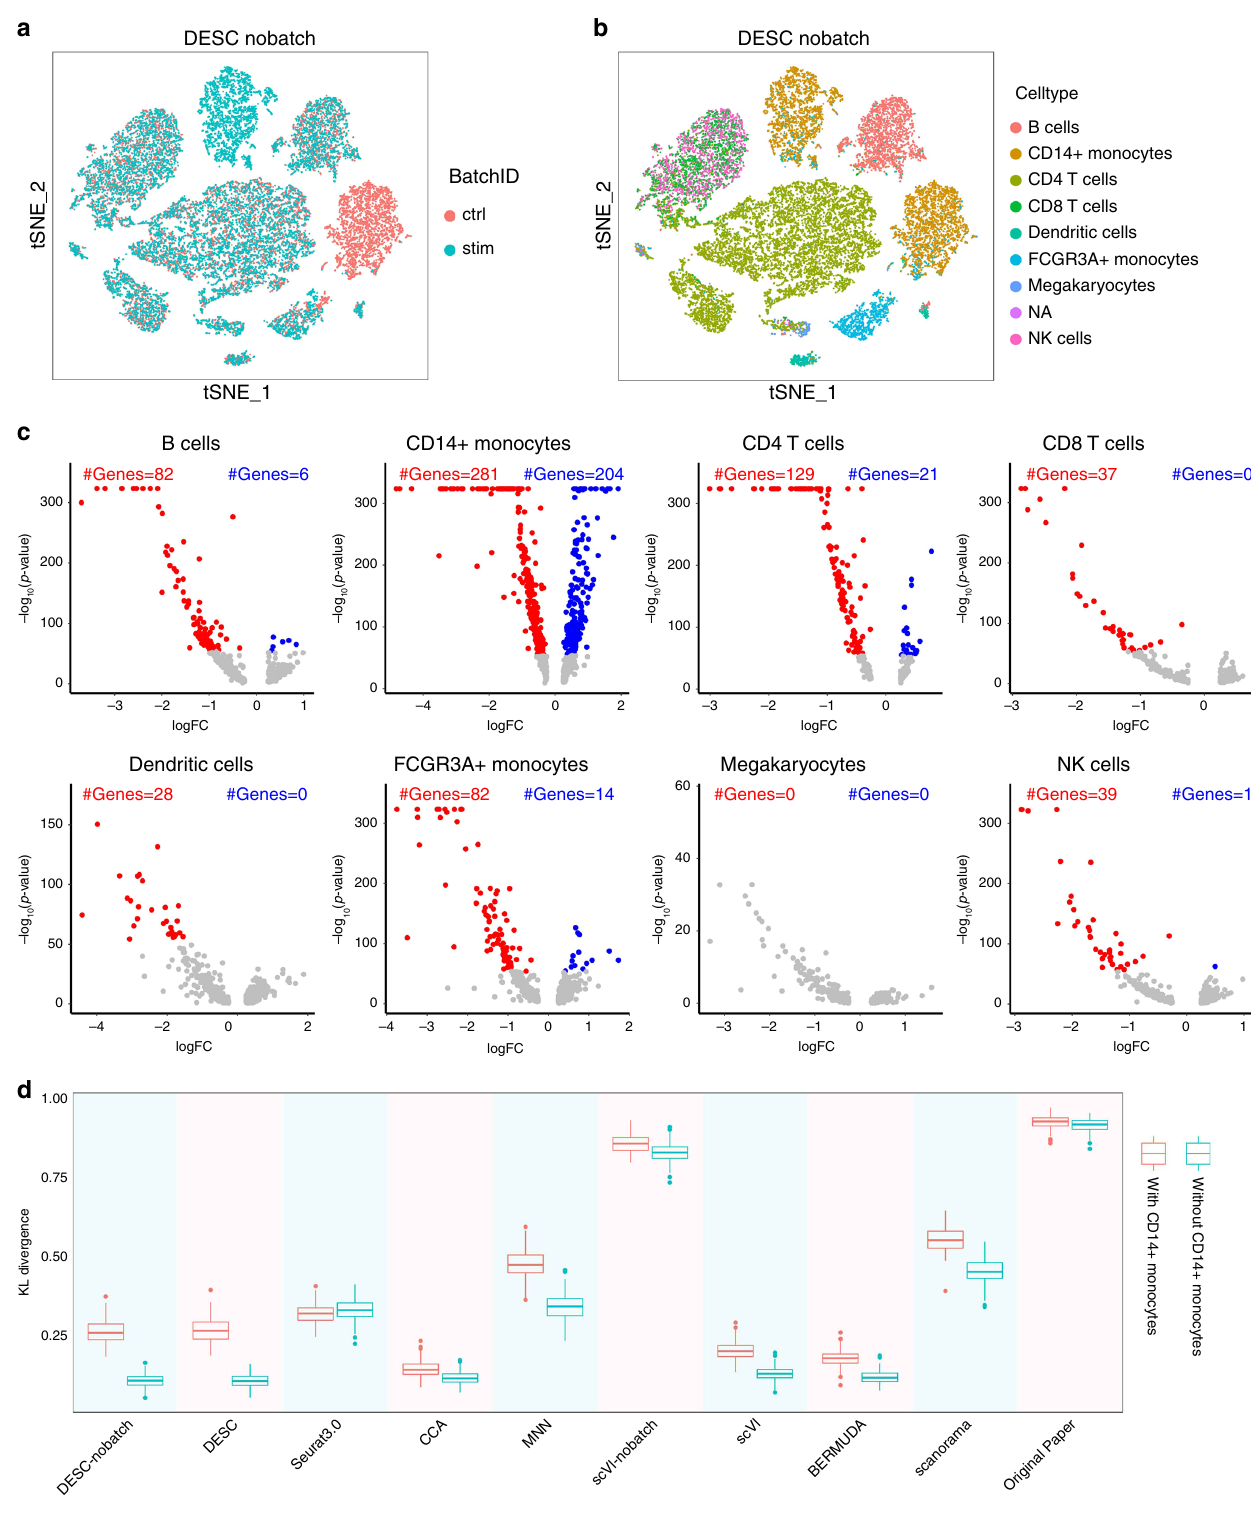
Fig. 5 The results of PBMC data generated by Kang et al. 18 . a, b DESC clustering without taking batch information in the analysis. a is colored by Batch ID and b is colored by cell type. c Volcano plots of differential expression analysis between control and stimulated conditions for each cell type. Highlighted are differential expression genes using Wilcoxon rank sum test with fold change > e 0.25 and FDR adjusted p value < 10 − 50 . CD14 + monocytes have the most number of differentially expressed genes compared with other cell types. d The KL divergence calculated using all cells and using non-CD14 + monocytes only. The box represents the interquartile range, the horizontal line in the box is the median, and the whiskers represent the 1.5 times interquartile